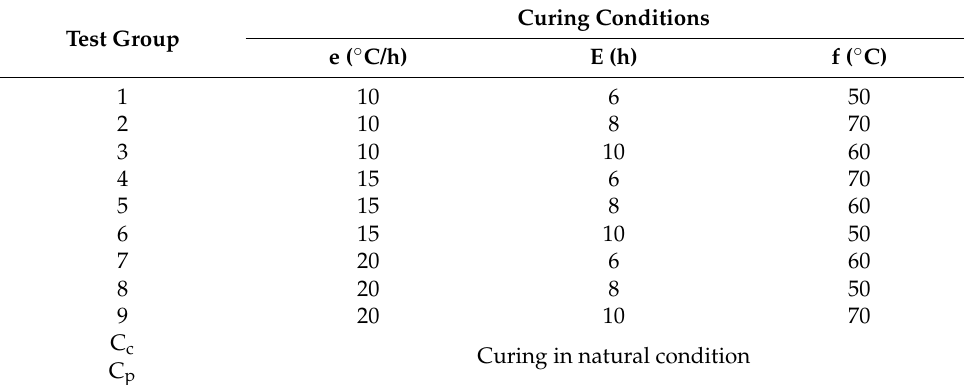
Table 4. The curing conditions of samples in this test.